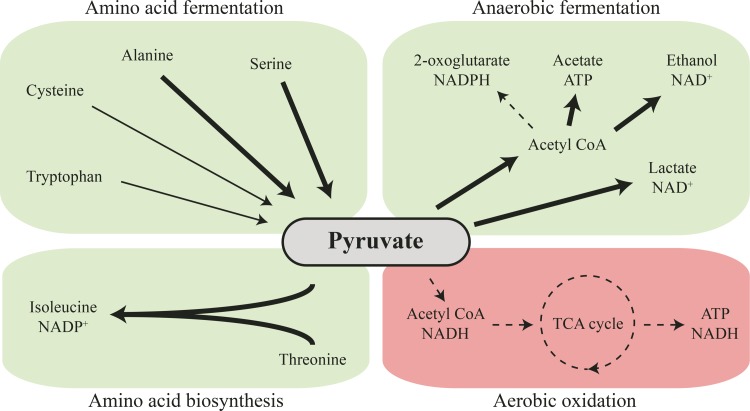
Global changes in cellular metabolism caused by activation of the SrrAB two-component system. Activation of the SrrAB two-component system causes a shift from aerobic oxidation toward anaerobic fermentation. Pathways that are repressed are shown by dashed arrows, and pathways that are overexpressed are shown by bold arrows.